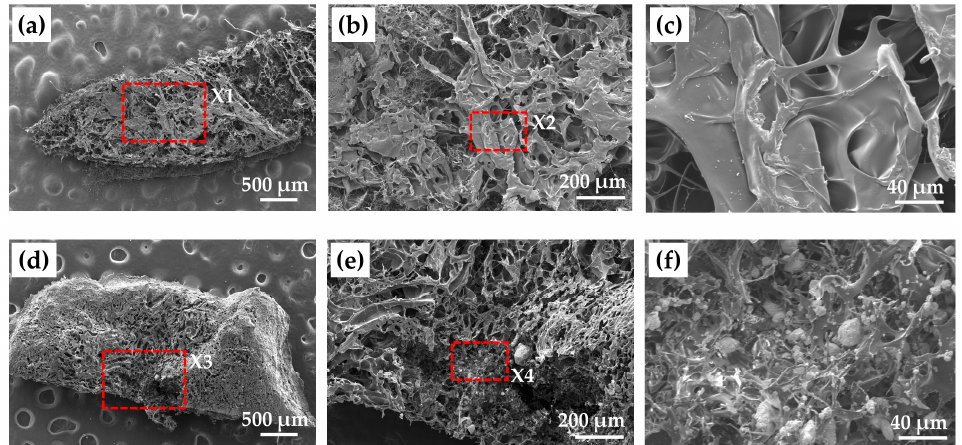
Figure 5. ( a ) Low-magnified scanning electron microscopy (SEM) image, ( b ) middle-magnified SEM image of the red square of X1 in ( a ), ( c ) high-magnified SEM image of the red square of X2 in ( b ) of dried cHLA/cAG composite; ( d ) low-magnified SEM image, ( e ) middle-magnified SEM image of the red square of X3 in ( d ), ( f ) high-magnified SEM image of the red square of X4 in ( e ) of dried cHLA/cAG/nHAp/BSA construct. Note: nHAp particles were seen on cHLA/cAG porous surface in ( d – f ).